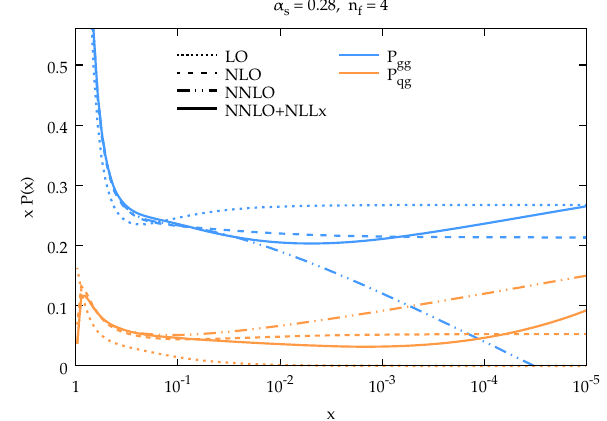
tion uncertainties (including the uncertainty due to variation of Q 0 mentioned above). The difference for the gluon distri-